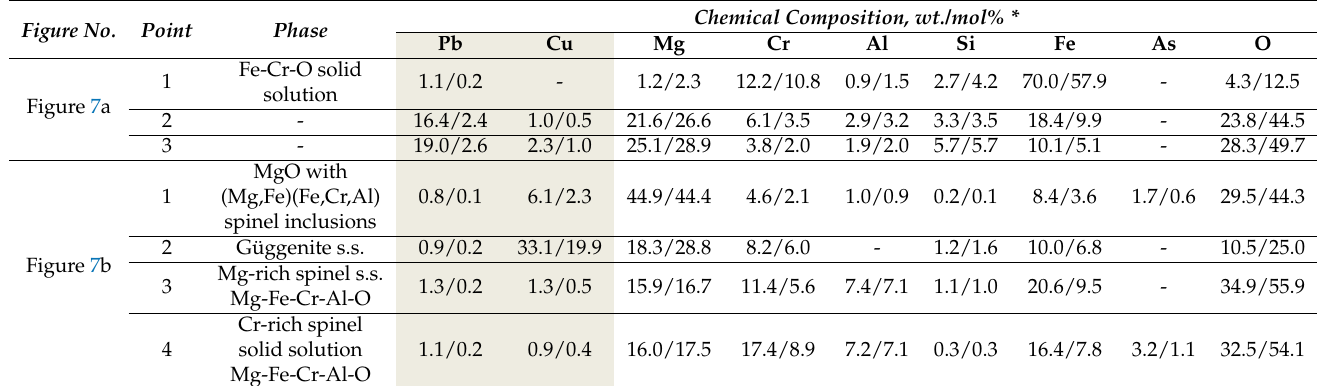
Table 6. EDS analysis in microareas of mixture FMC 45 + slag after corrosion, in the points marked in Figure 7, together with corresponding phases. Figure No. Point Figure 7a